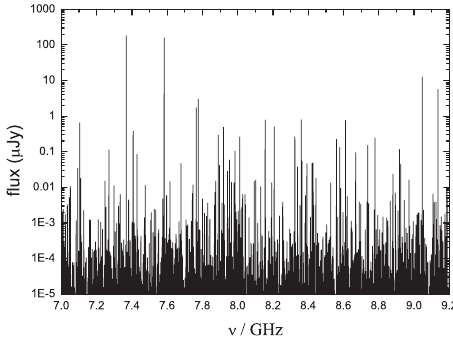
Figure 3. A simple example (flux versus frequency) for the coherent radio emission from an ultracool